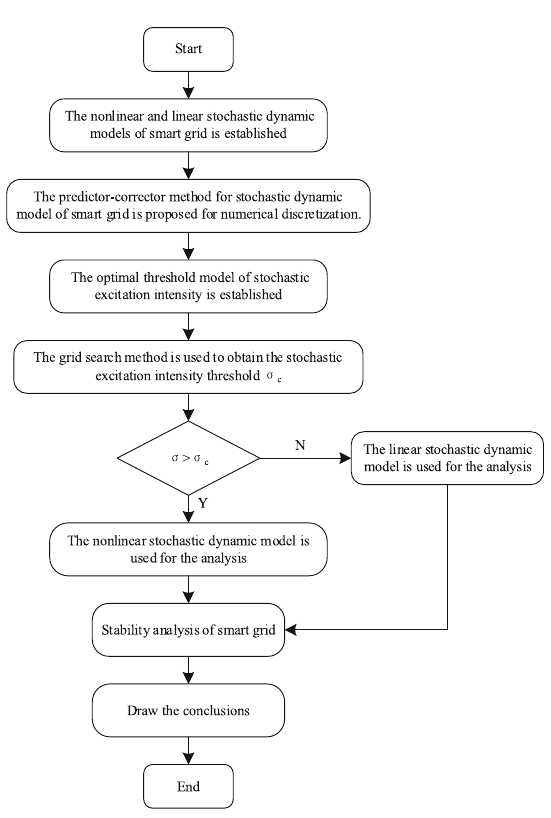
Fig. 1 Stability analysis process